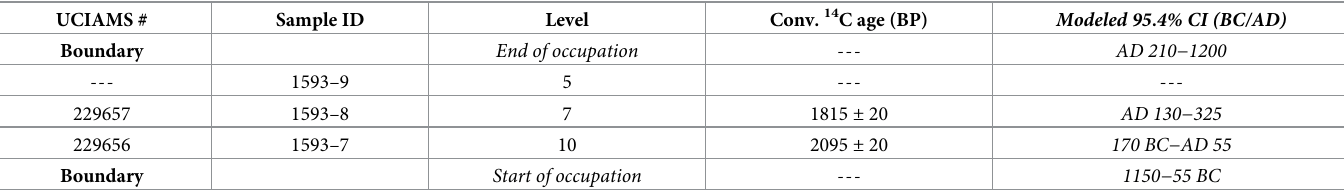
Table 6. Radiocarbon dates for unit SE5F, including modeled sequence, 95% probability ranges, and boundaries. UCIAMS #